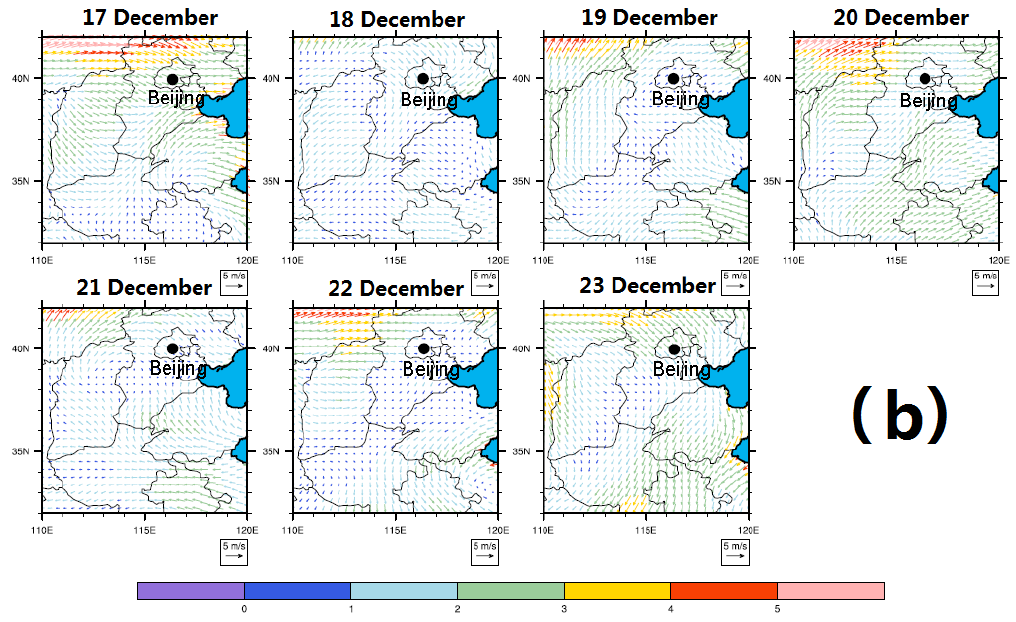
Figure 2. The daily average wind fields at ( a ) 850 hPa and ( b ) the surface during 17–23 December in the Beijing area (ERA-Interim dataset).